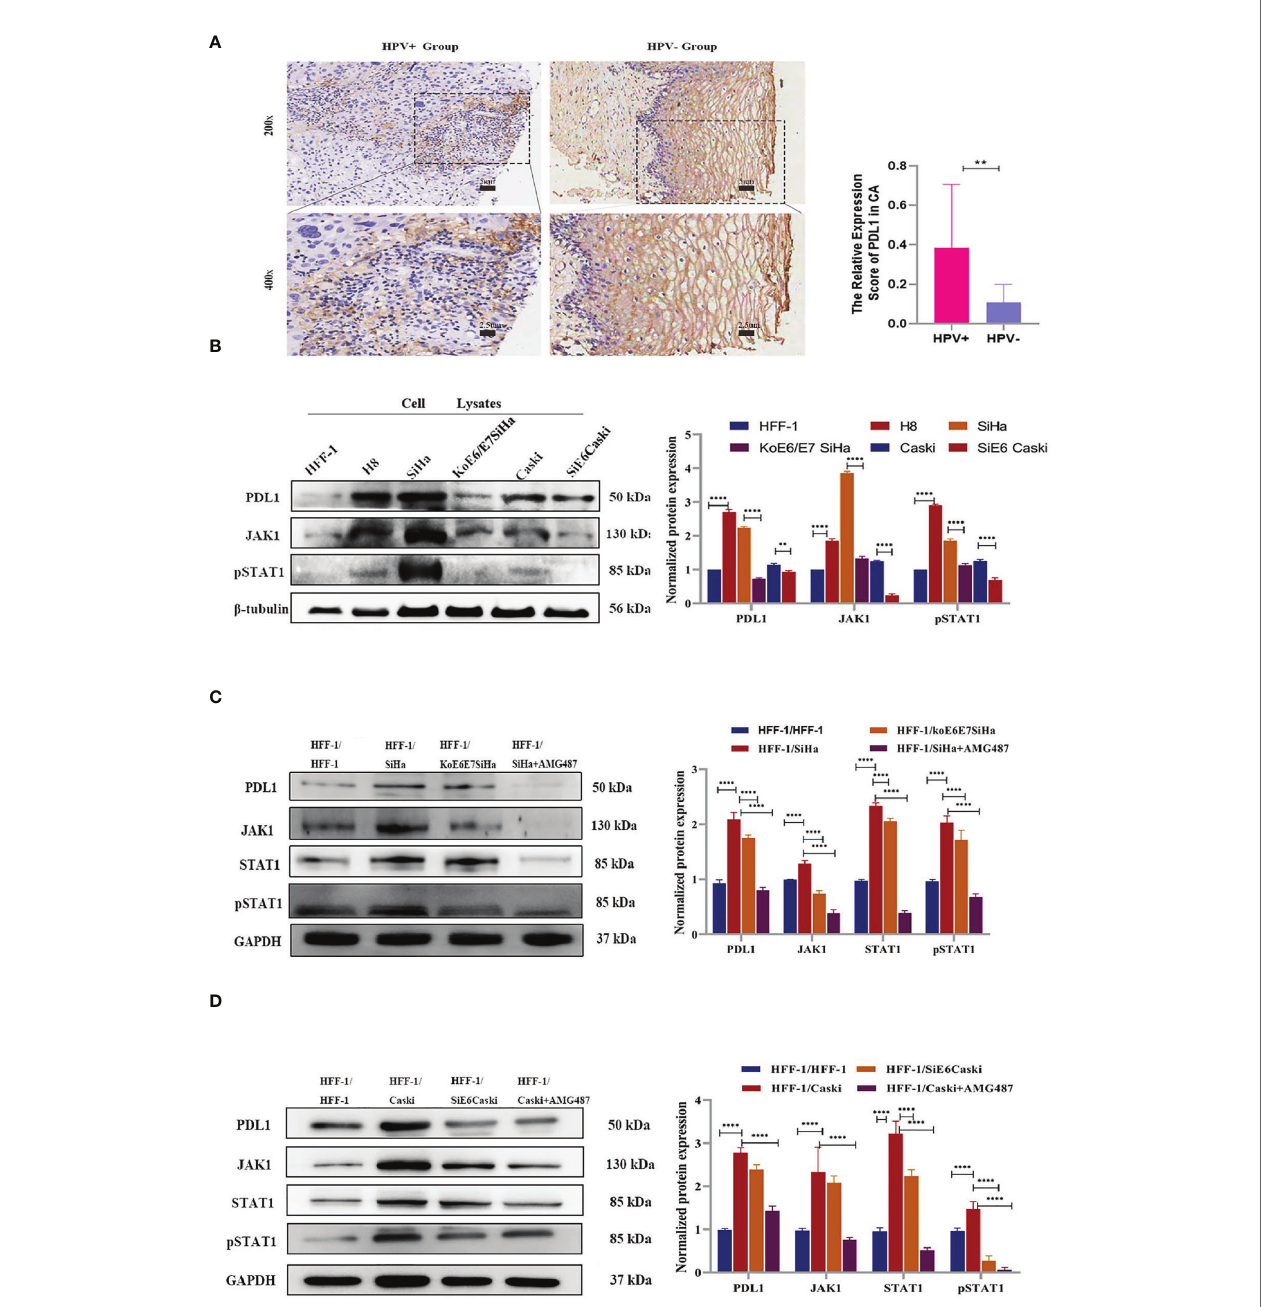
FIGURE 3 | Through transwell co-culture with HPV+ cells (SiHa and Caski), PD-L1 expression in HFF-1 cells were induced by CXCL10-CXCR3 interaction, while were decreased after co-culture with the HPV+ cells which E6 and E7 has been knocked down or treatment with AMG487. (A) Immunohistochemistry revealed that the expression of PD-L1 had a strong relationship with HPV infection in cervix tissues, which showed the higher expression of PD-L1 in CSCC (HPV+ Group) than that of a normal cervical epithelium (HPV- Group); (B) The expression of PD-L1, JAK1 and pSTAT1 in different cells was tested by western blotting. The band intensities were calculated using the ImageJ software. GAPDH was used as an internal control for the total protein measurement. The ratio of the target gene to GAPDH was used to conduct the statistical analysis. (C, D) . Compared to the co-culture with HFF-1 cells, the expression levels of PD-L1, JAK1 and pSTAT1 in HFF-1 cells were all upregulated following co-culture with HPV+ cells (SiHa, Caski) while the upregulation of JAK1 and pSTAT1 were diminished after co-culture with koE6/E7Siha and SiE6Caski cells or treatment with AMG487 using the 0.4 µm polycarbonate membrane transwell assay, in which cells could not pass through. *P < 0.05, **P < 0.01, ***P<0.001 and ****P < 0.0001, as determined by Student ’ s